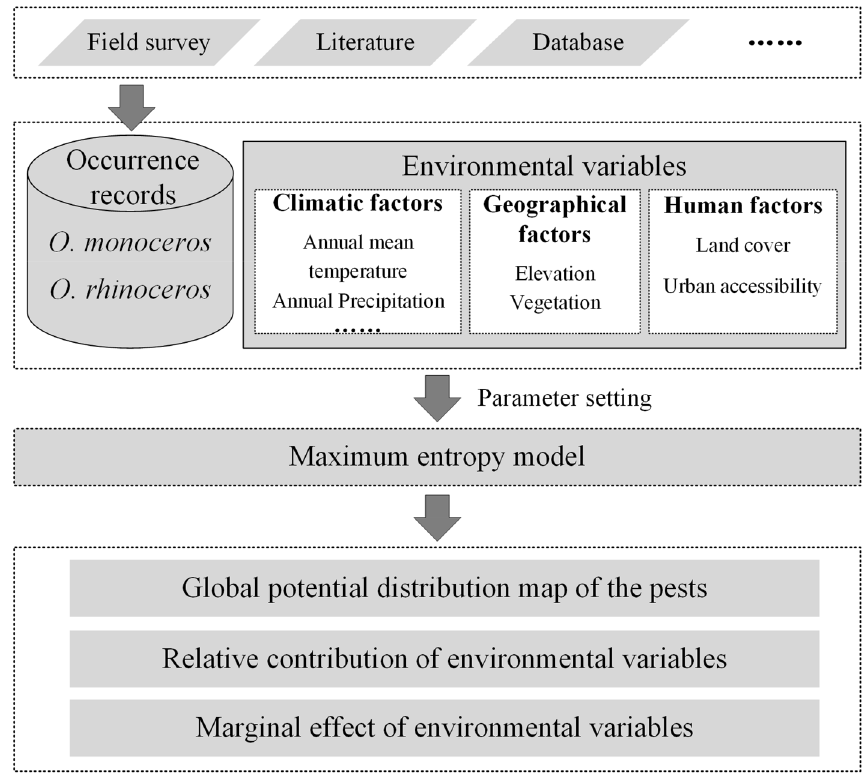
Figure 1. Technical flow chart of